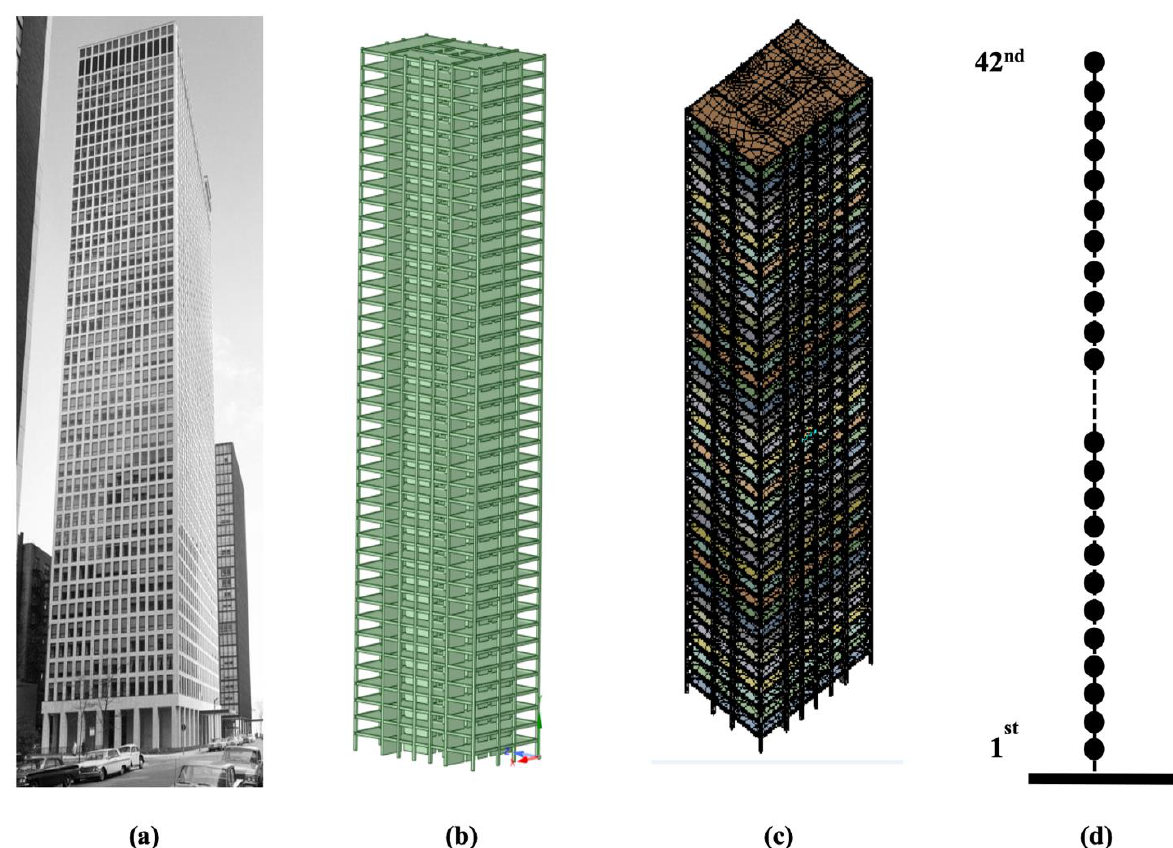
Figure 1. The case study hybrid-timber building: ( a ) DeWitt Chestnut apartments, Chicago, ( b ) FEM of proposed timber building, ( c ) meshing in ANSYS, and ( d ) lumped mass model. of proposed timber building, ( c ) meshing in ANSYS, and ( d ) lumped mass